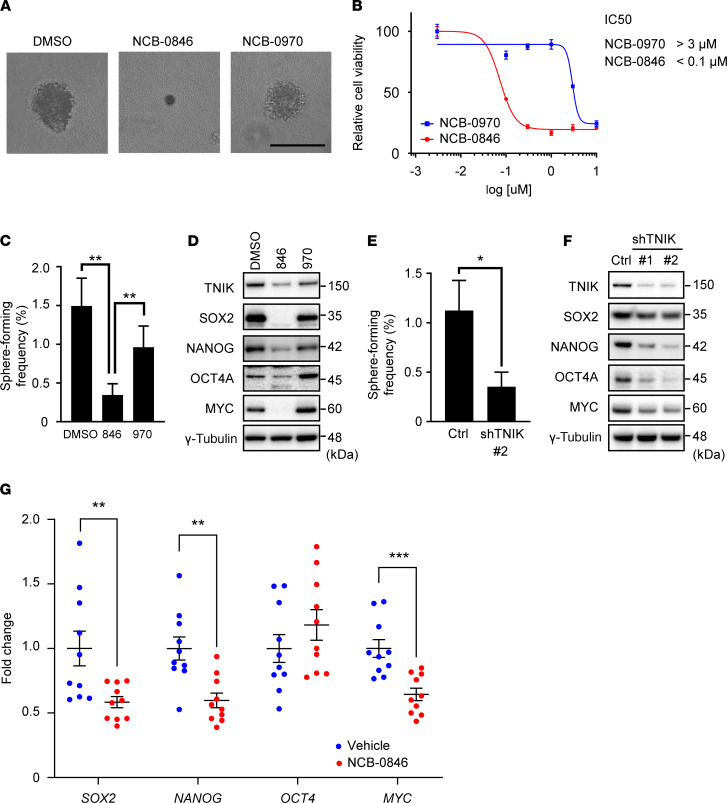
TNIK inhibition abrogates OS stemness.(A and B) Anchorage-independent colony formation by OS cells. U2OS cells were embedded in soft agar; covered by media containing DMSO alone (control), 1 μM NCB-0846, or 1 μM NCB-0970; and cultured for 14 days. (A) Representative images of colonies are shown (scale bar: 100 μm). (B) Relative cell viability was determined colorimetrically at 450 nm (n = 4). Data represent the mean ± SD. (C) Frequency of sphere formation by OS cells. U2OS cells were treated with DMSO, 1 μM NCB-0846, or 1 μM NCB-0970 for 3 days. The frequency of sphere formation and statistical significance were calculated using Extreme Limiting Dilution Analysis (ELDA) software. **P < 0.01. (D) Immunoblot analysis of TNIK and transcription factors related to cancer stemness (SOX2, NANOG, OCT4A, and MYC) in U2OS cells treated with DMSO, 1 μM NCB-0846, or 1 μM NCB-0970 for 72 hours. (E) TNIK knockdown suppresses the sphere-forming activity of OS cells. USO2 cells stably expressing shCtrl (Ctrl) or shTNIK (#2) were distributed into 96-well U-bottomed culture clusters at a density of 1, 10, or 100 cells per well and cultured for 14 days. The frequency of sphere formation and statistical significance were calculated using the ELDA software. *P < 0.05. (F) Immunoblot analysis of TNIK, proteins related to cancer stemness (SOX2, NANOG, OCT4A, and MYC), and γ-tubulin (loading control) in U2OS cells stably expressing shCtrl or shTNIK clone 33 (#1) and clone 35 (#2). (G) Expression of the SOX2, NANOG, OCT4, and MYC genes (normalized to ACTB) in NOS-10 xenografts excised from immunodeficient mice administered water (vehicle, n = 10) or 80 mg/kg NCB-0846 HCl (n = 10). Student’s t test, **P < 0.01, ***P < 0.001. Data represent the mean ± SEM.